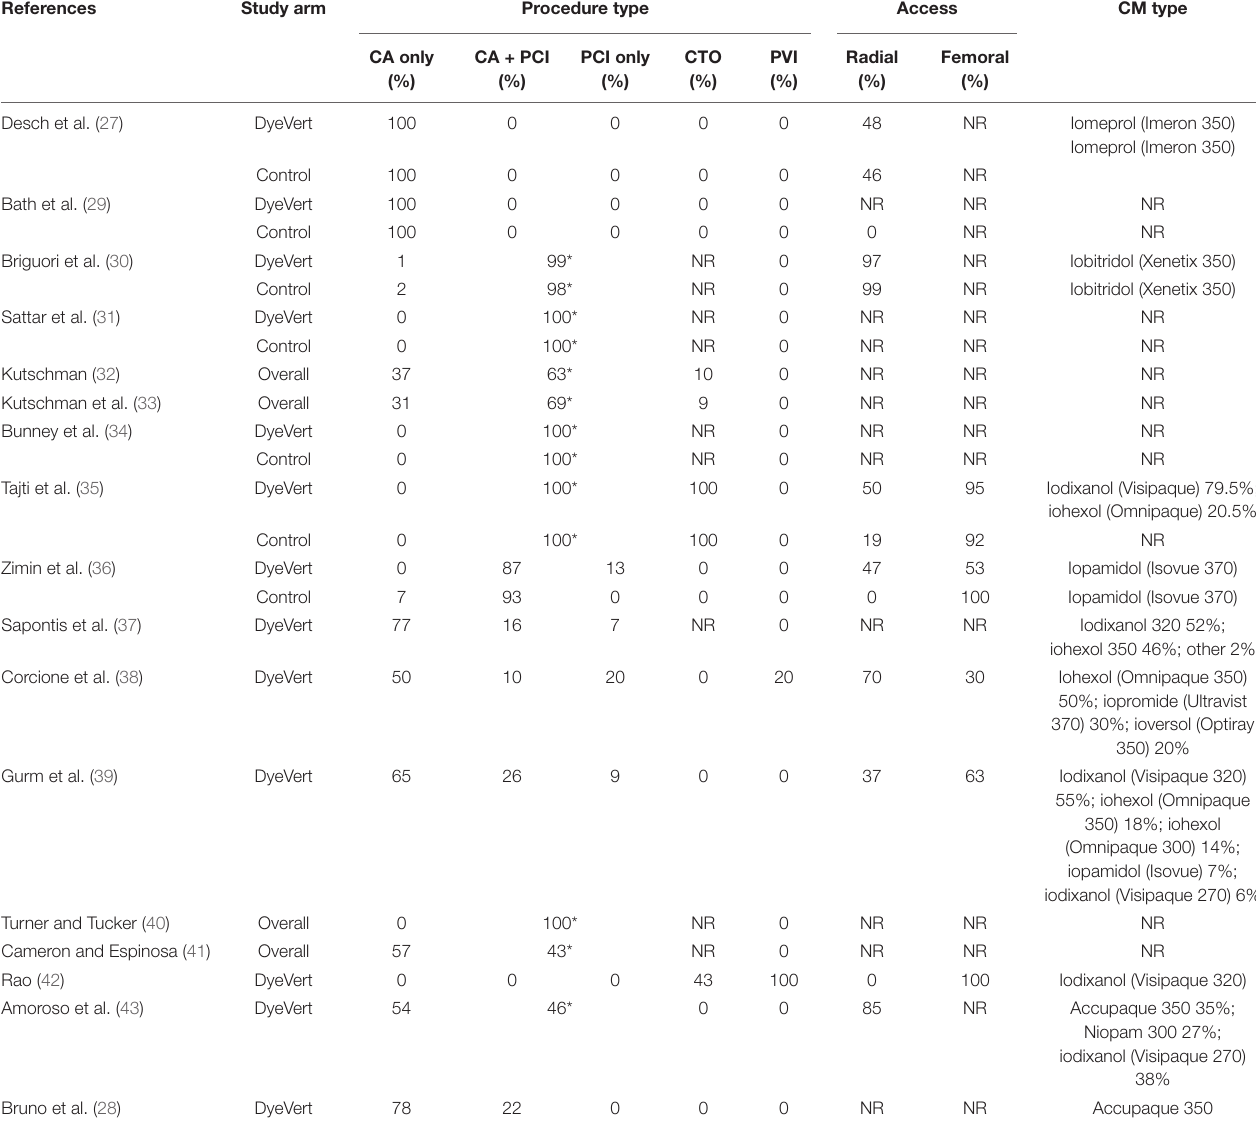
TABLE 3 | Procedure characteristics across included